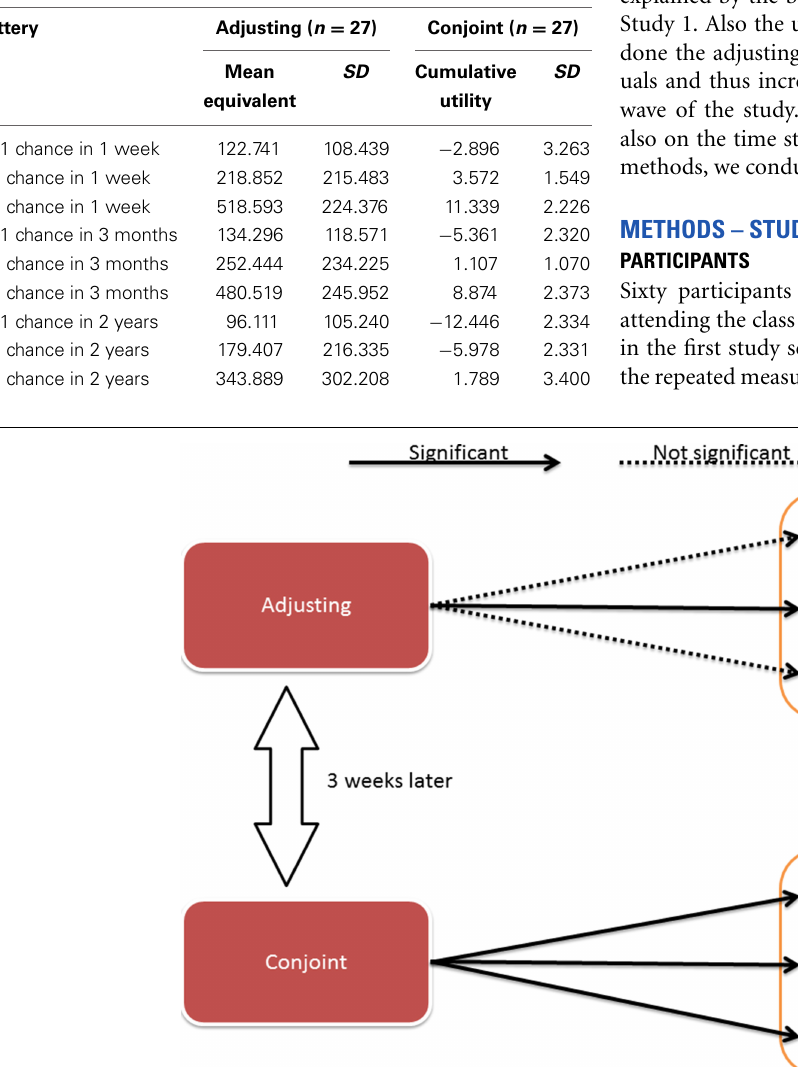
Table 2 | Discounting equivalents (cumulative utilities) calculated for each lottery with adjusting (conjoint) method within Study 1.